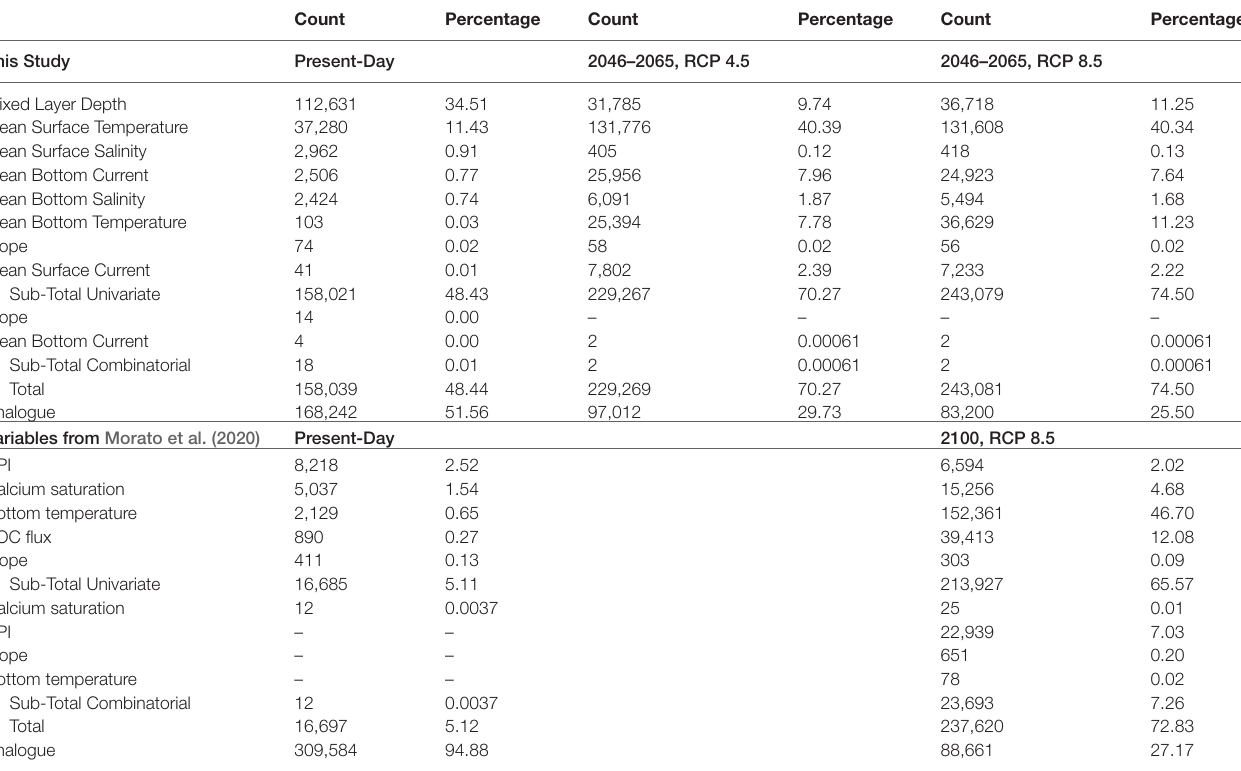
TABLE 2 | Spatial extent (in number of grid cells) of extrapolation for single covariates and combinations of covariates under present-day and future climatologies based on presence and absence data for Paragorgia arborea